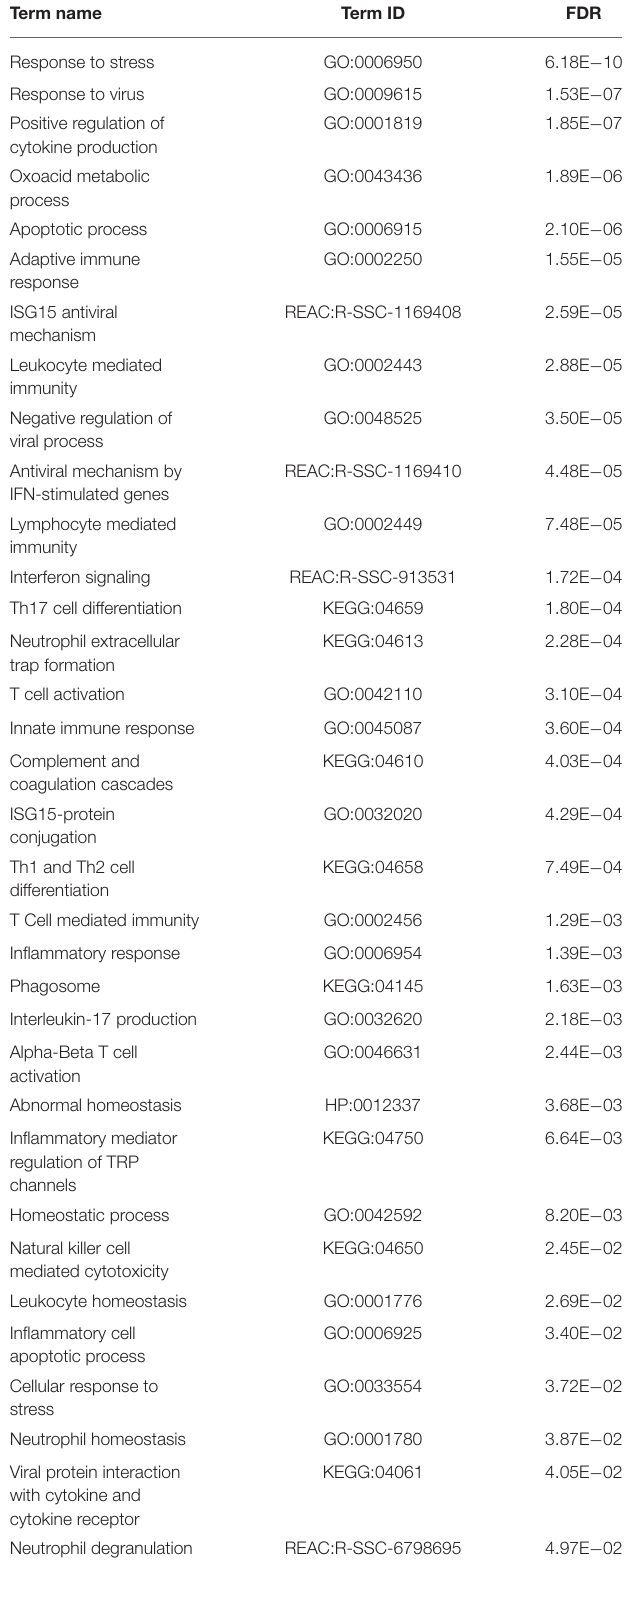
TABLE 1 | MLV-ATP GO terms related to immunity, stress, and homeostasis in porcine